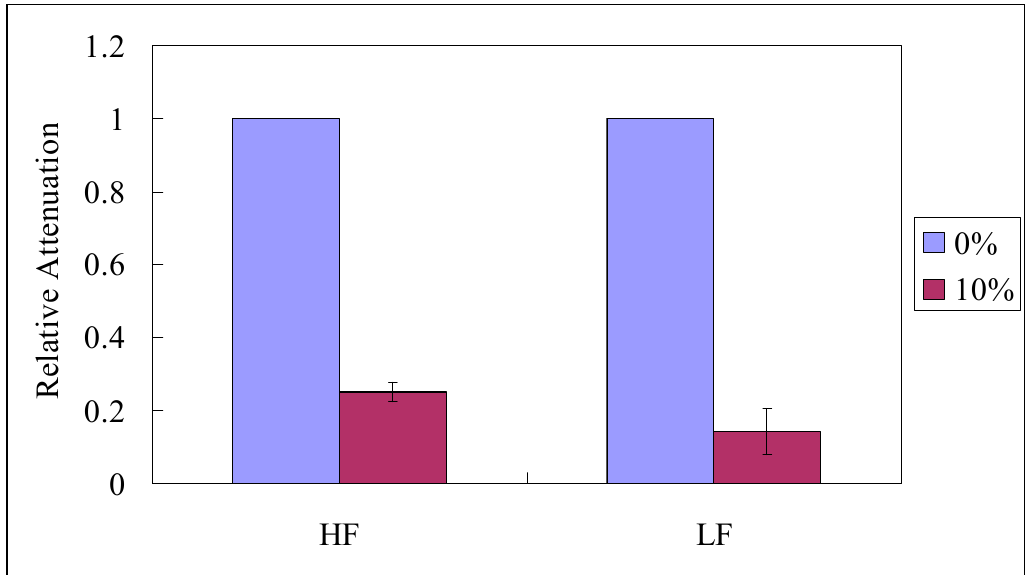
Figure 14. The relative attenuation with 10% deformation for HF and LF samples.